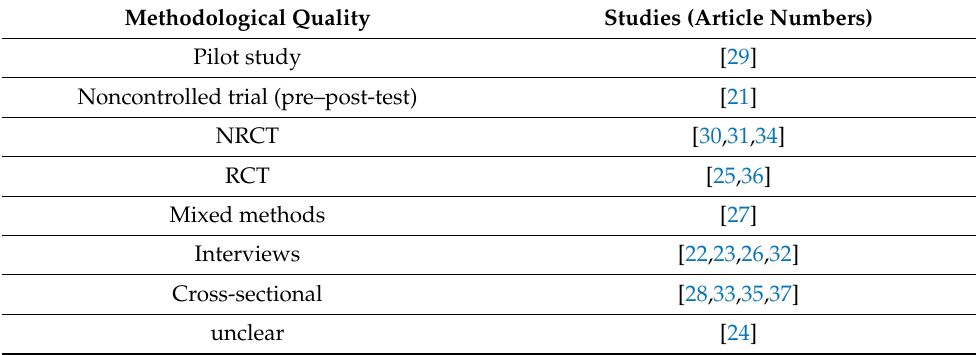
Table 4. Studies categorised by methodological